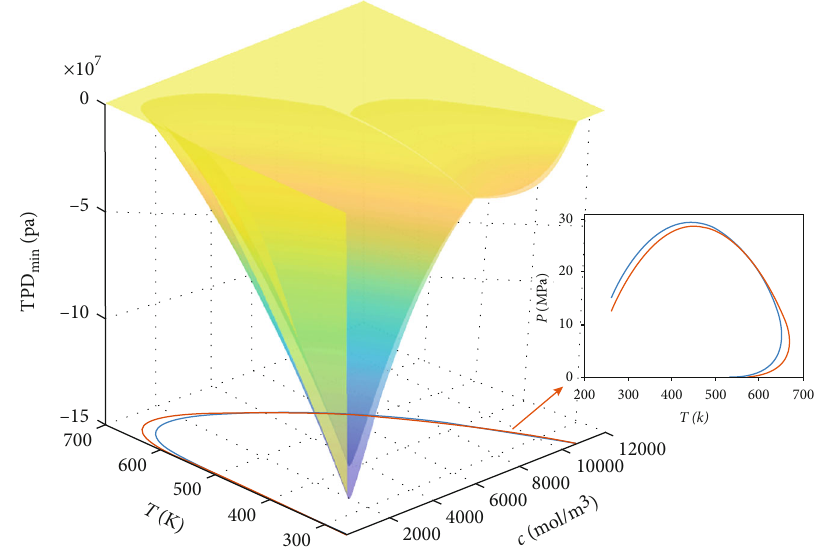
Figure 5: Global minimum of TPD function, as well as corresponding phase envelope, as a function of the overall molar density and temperature for an Eagle Ford oil with (red line) or without (blue line)